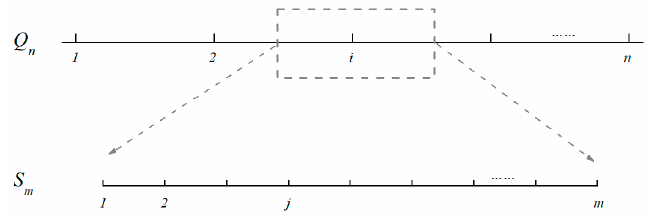
Figure 1. Schematic diagram of sampling methods for time